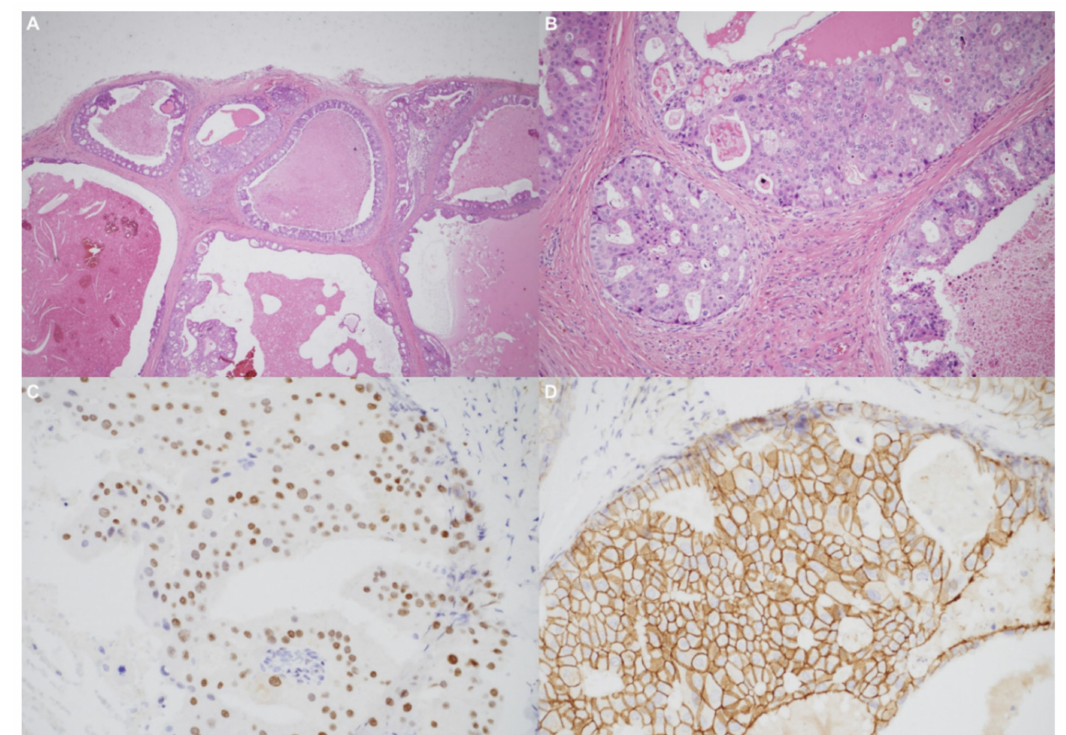
Figure 5. ( A ) The tumor resembled high-grade ductal carcinoma of the breast. Large ducts with comedo necrosis and Roman-bridge-like features are evident. Original magnification × 20. ( B ) A cribriform architectural pattern was observed. Original magnification × 200. ( C ) Immunohistochemical staining produced diffusely positive signals for the androgen receptor. ( D ) Significant human epidermal growth factor receptor 2 expression was